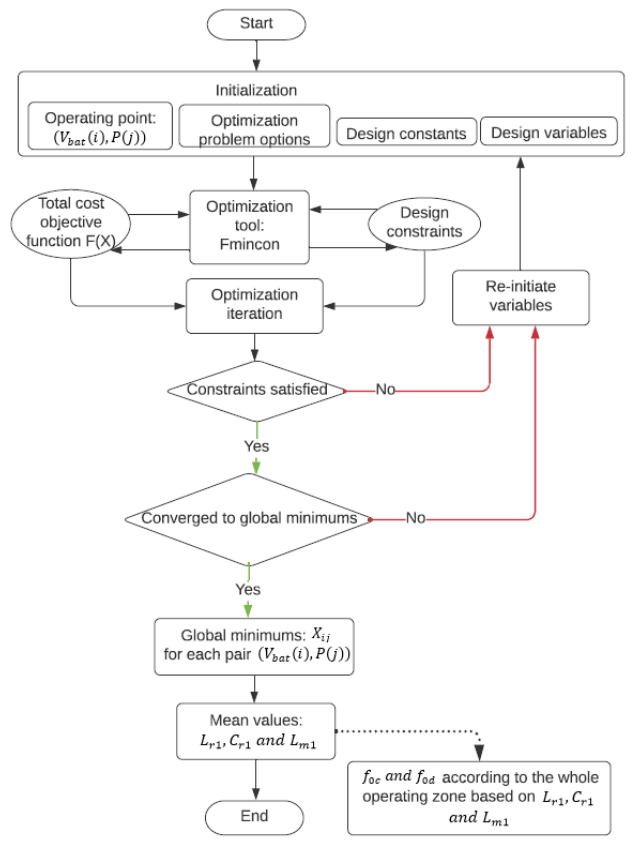
Figure 12. Optimization flow